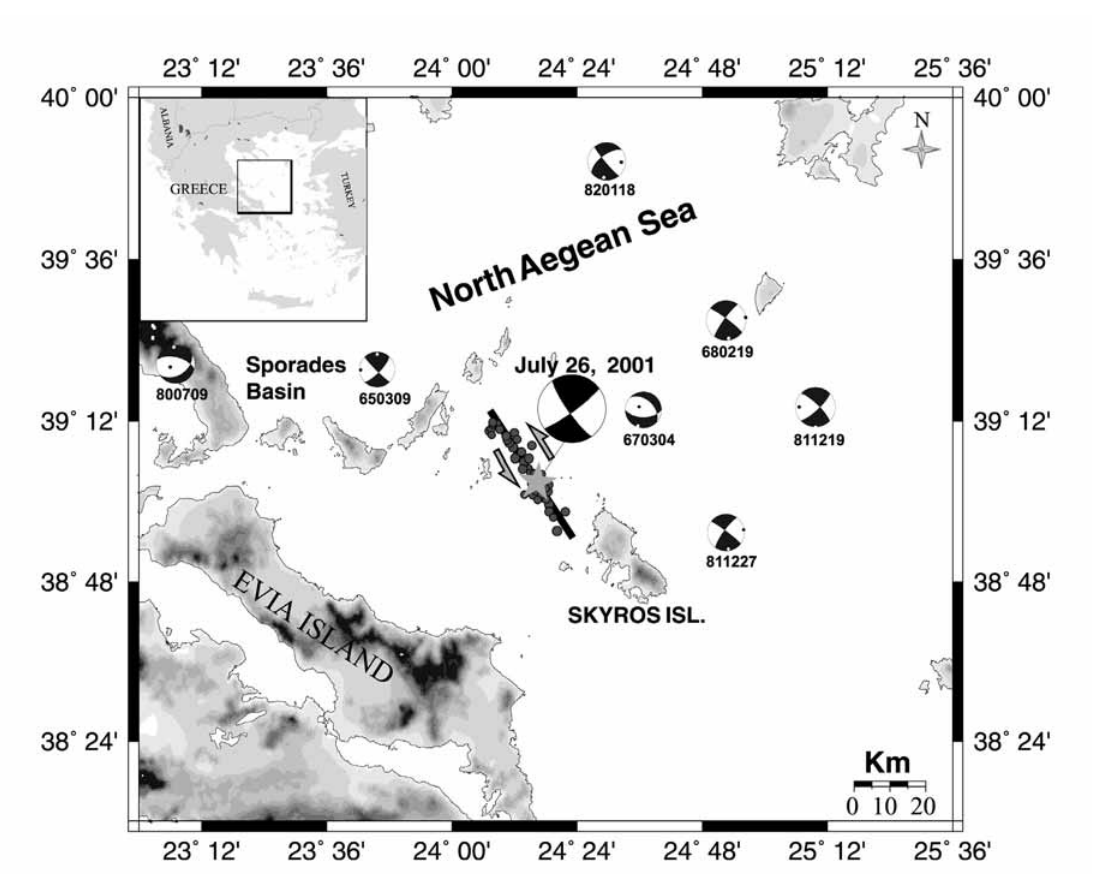
Fig. 7. Regional map showing the focal mechanism of the Skyros mainshock, the distribution of the aftershocks, the orientation of the fault that moved during the earthquake, and other focal mechanisms previously determined. The activation of an NW-SE striking fault is